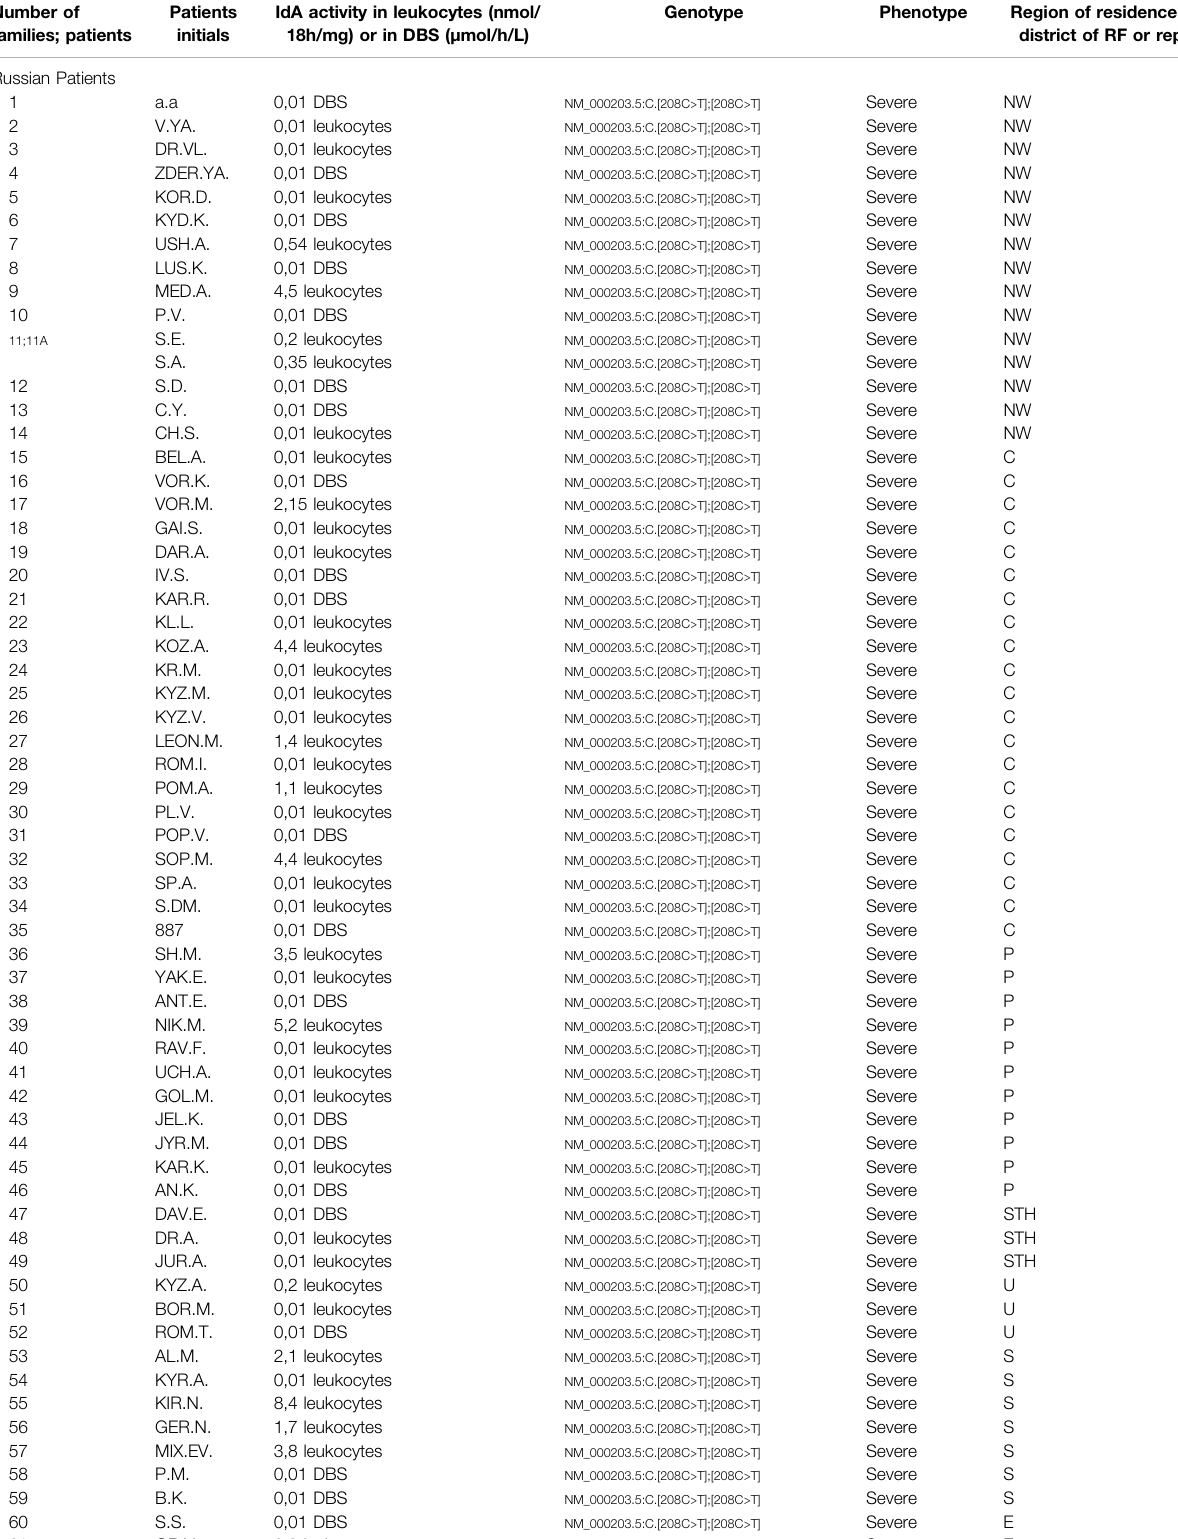
TABLE 1 | Genotype and phenotype of patients with an indication of the place of residence and nationality. Number of families;